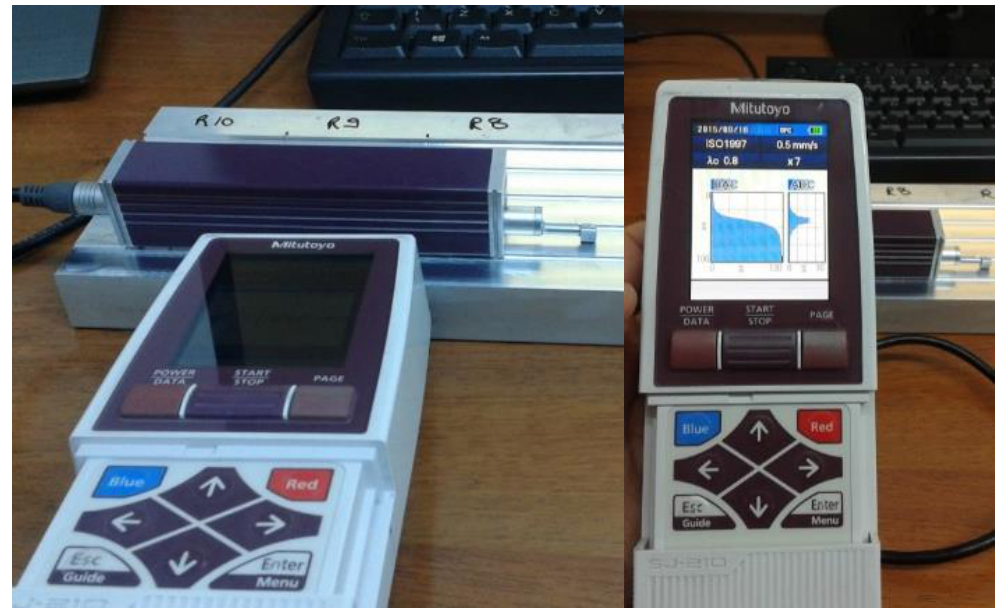
Figure 6. The measurements made with Mitutoyo SURFTEST SJ-210.